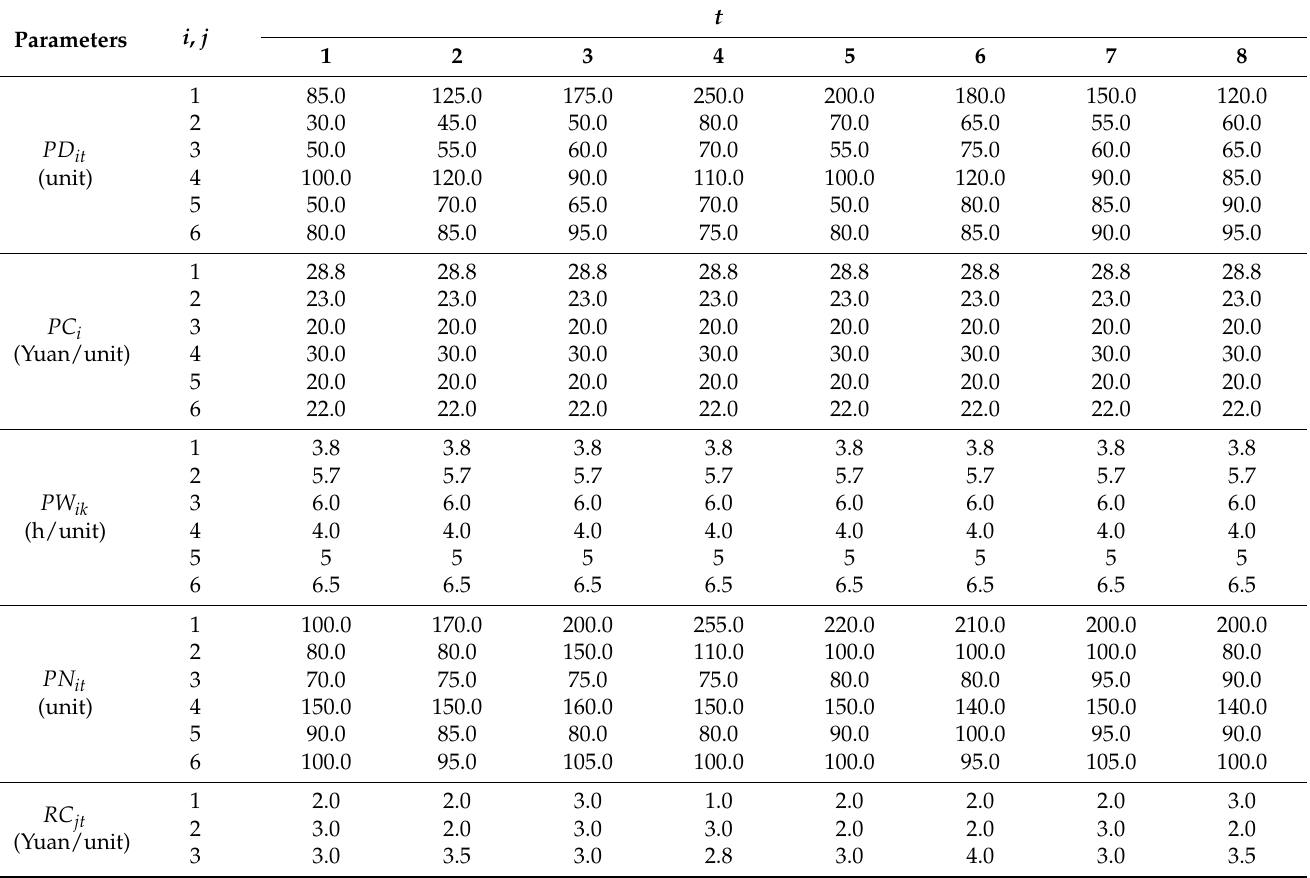
Table A2. Parameters of production and raw materials.